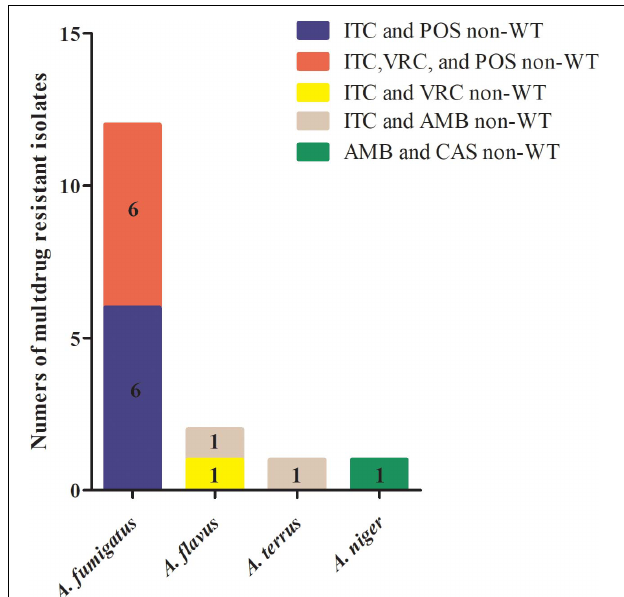
FIGURE 1 | Multidrug-resistant Aspergillus spp. isolates collected in China from 1999 to 2019. Among 16 multidrug-resistant isolates of Aspergillus spp., six Aspergillus fumigatus isolates were cross-resistant to itraconazole (ITC) and posaconazole (POS); six A. fumigatus isolates were cross-resistant to ITC, voriconazole (VRC), and POS; one Aspergillus flavus isolate was cross-resistant to ITC and VRC; one A. flavus and one Aspergillus terreus isolate were co-resistant to ITC and amphotericin B (AMB); and one Aspergillus niger isolate was co-resistant to AMB and caspofungin